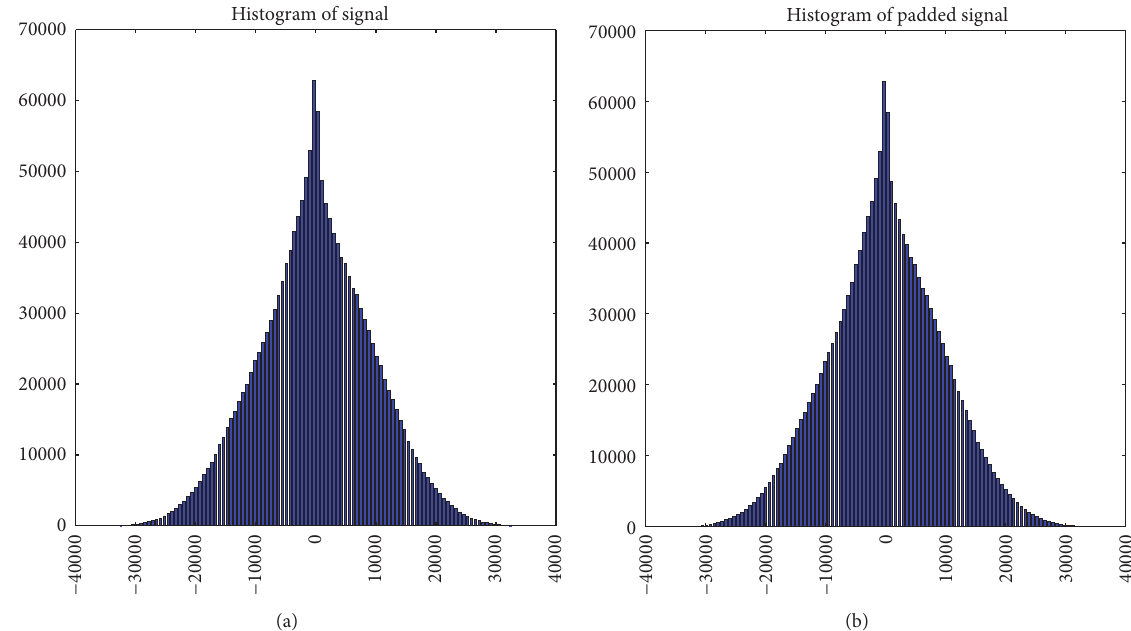
Figure 1: Comparison of signal histograms. (a) Before padding; (b) after padding.